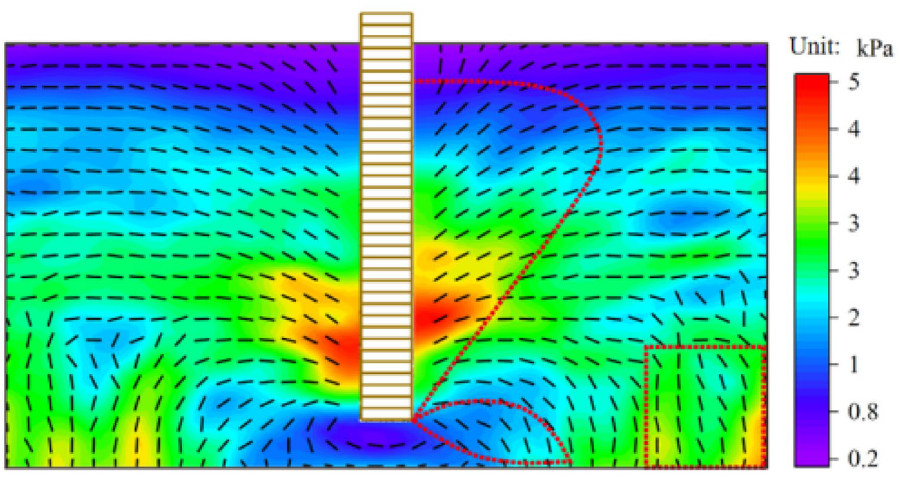
Figure 15. Large principal stress and direction vector diagram.